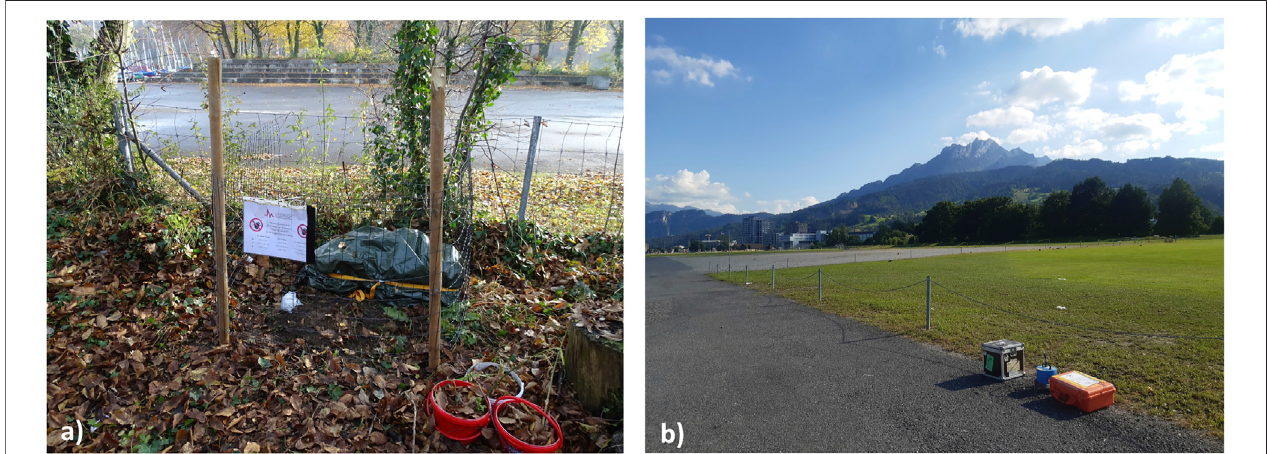
FIGURE4|(A) LUZ02 — exampleofthestationofthetemporarynetwork. (B) ExampleofmeasurementofambientnoiseduringthesurveyinJune2020.Thesetup consists of a Lennartz 5-s sensor and Centaur